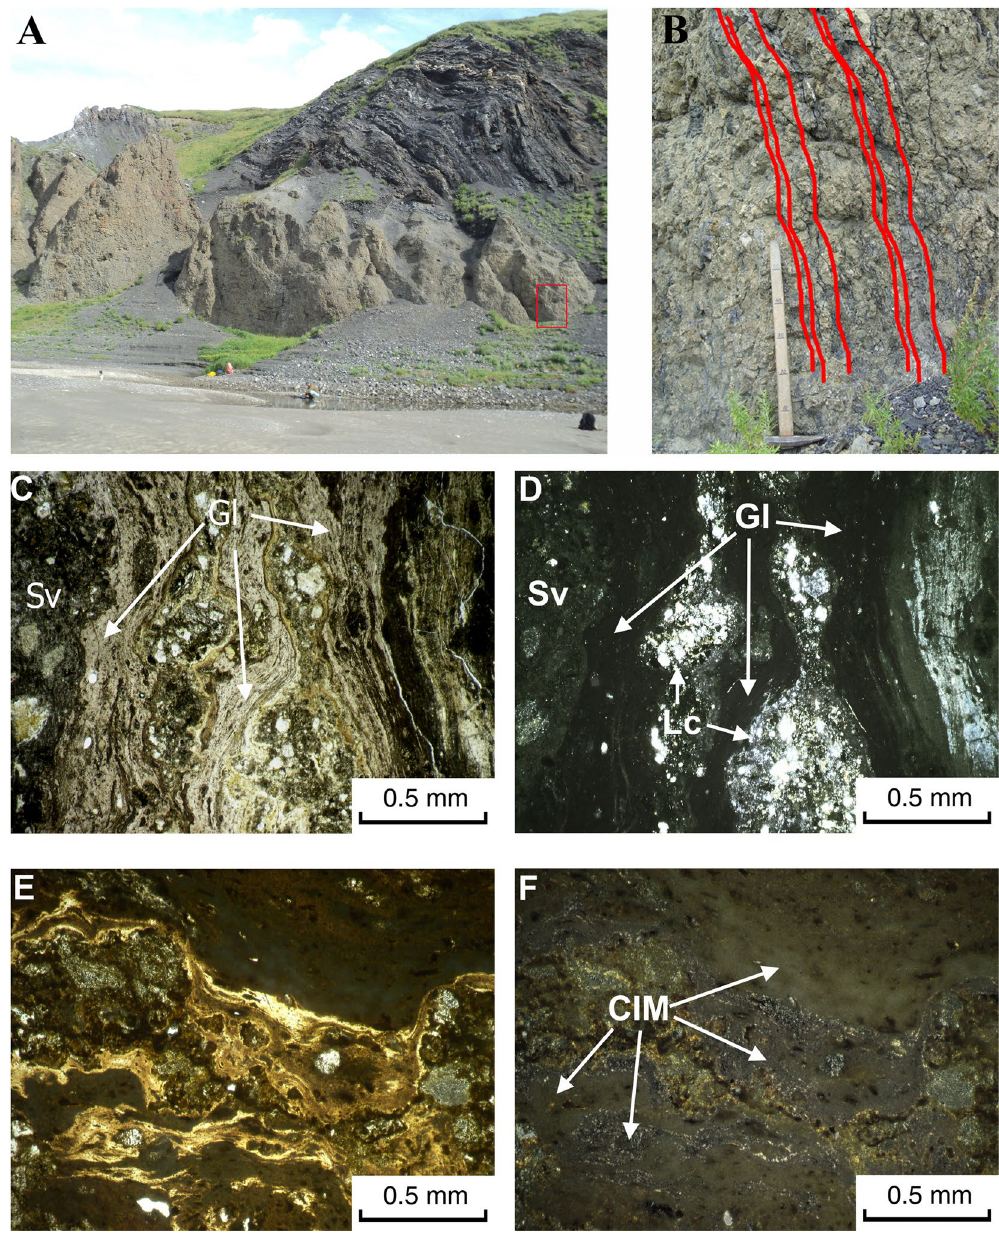
Figure 1. Massive impactite with vein-like ultrahigh pressure melt glasses in contact with black shales of the Kara astrobleme target. ( A ) Outcrop on the right bank of the Kara river, ( B ) magnified part (red square in ( A )), red lines tracing the vein-like bodies of UHPHT melt glasses. ( C – E ) thin sections in transparent light, ( C , E ) parallel polarizers, ( D , F ) crossed polarizers; ( C , D ) UHPHT glass (Gl) in suevite (Sv) transporting lithoclasts (Lc). ( E , F ) crystallized impact melt (CIM) clast, CIM clast within suevite. Photos and microimages were made by